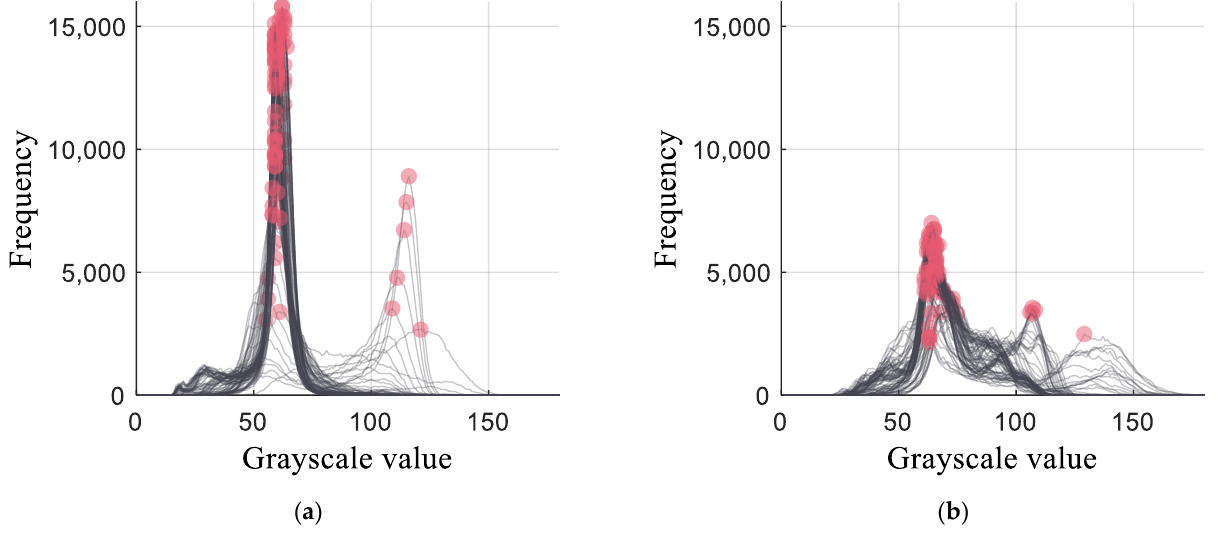
Figure 12. Grayscale histogram at the fracture zone of ( a ) MART1500 specimen with the highest HER and ( b ) MART1500 specimen with the lowest HER.